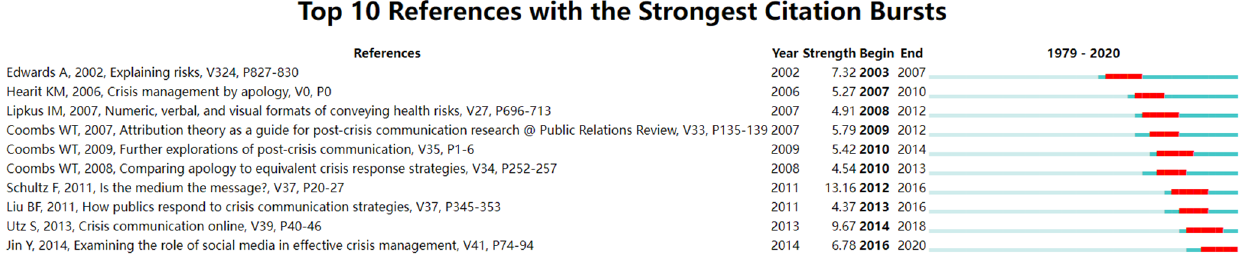
Figure 10. Top 10 references with the strongest citation bursts.